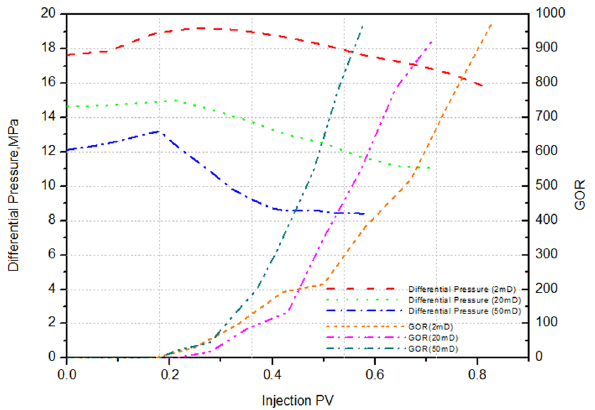
Fig. 3 Low oxygen air flooding curves for long core with perme- ability of 2, 20 and 50